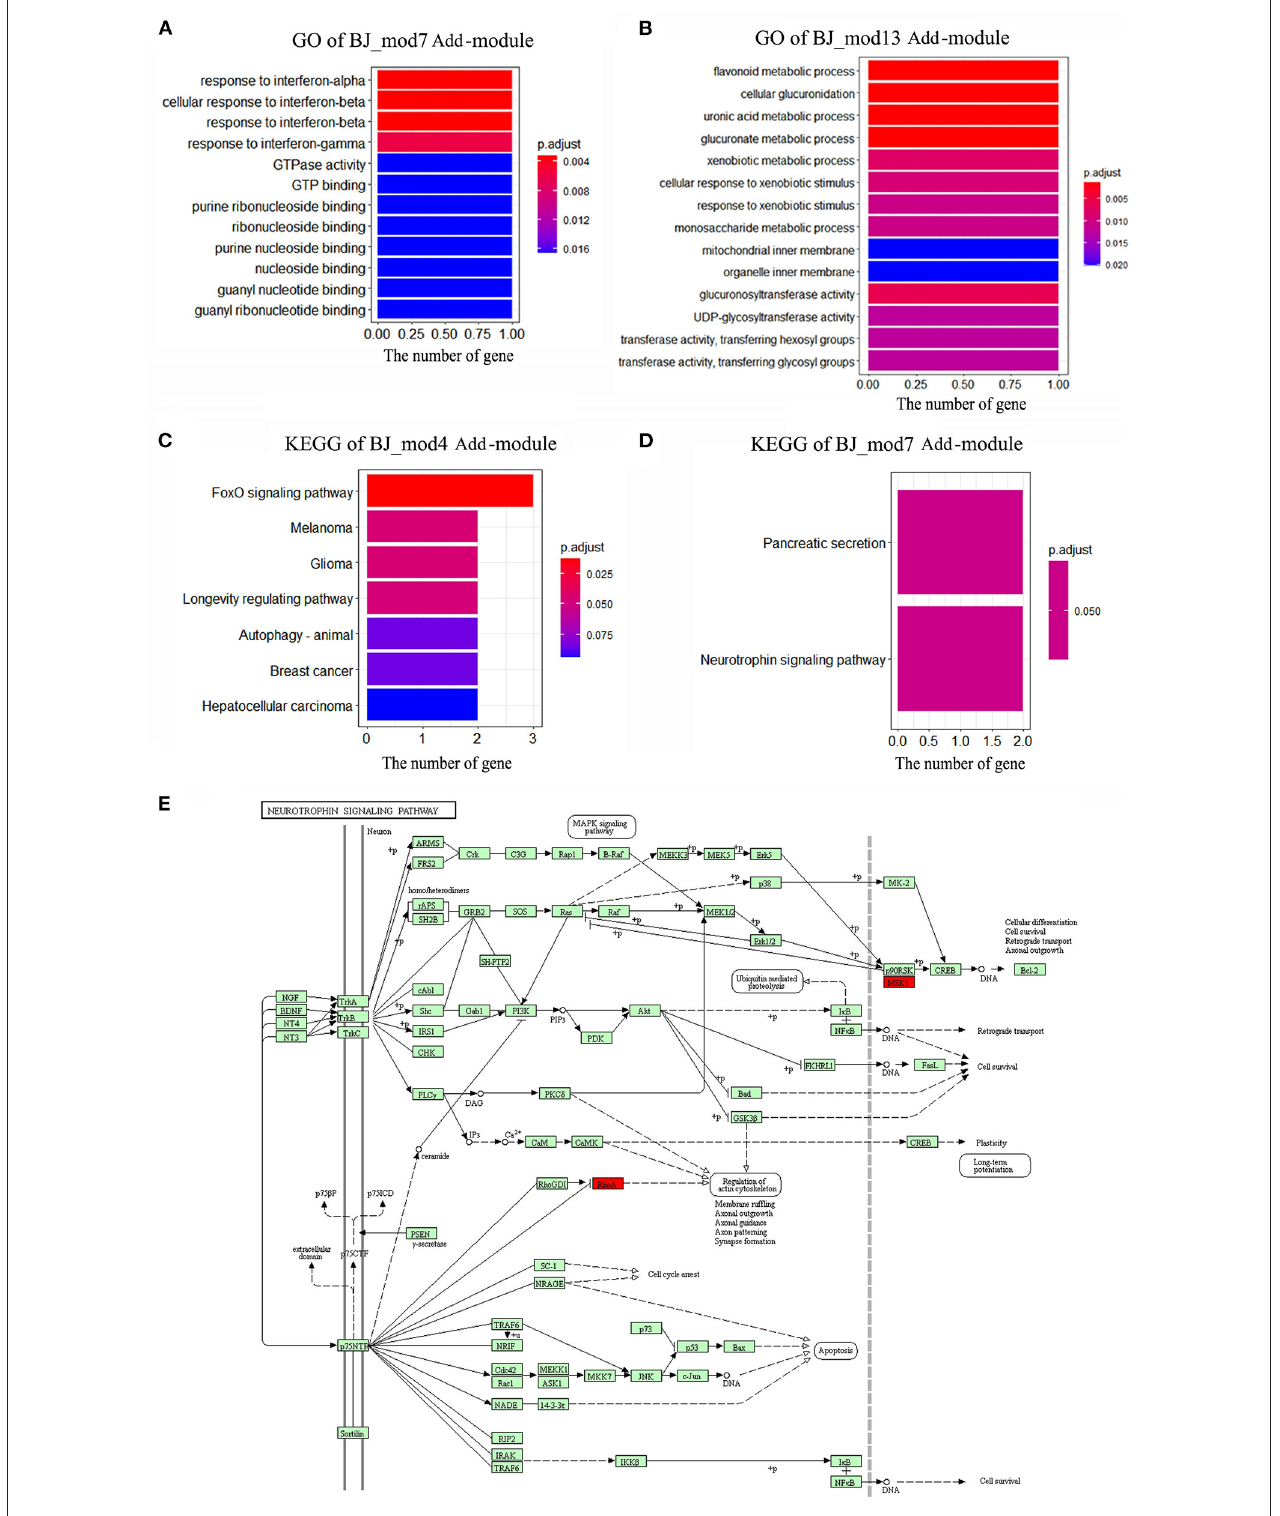
FIGURE 6 | The enriched functions of BJ Add-modules. (A) The significant Gene ontology (GO) terms enriched by BJ-Mod 7. (B) The significant GO terms enriched by BJ-Mod 13. (C) The significant Kyoto Encyclopedia of Genes and Genomes (KEGG) pathways enriched by BJ-Mod 4. (D) The significant KEGG pathways enriched by BJ-Mod 7. (E) The representative Neurotrophin signaling pathway enriched by BJ-Mod 7, and the driver genes of BJ are labeled as red.